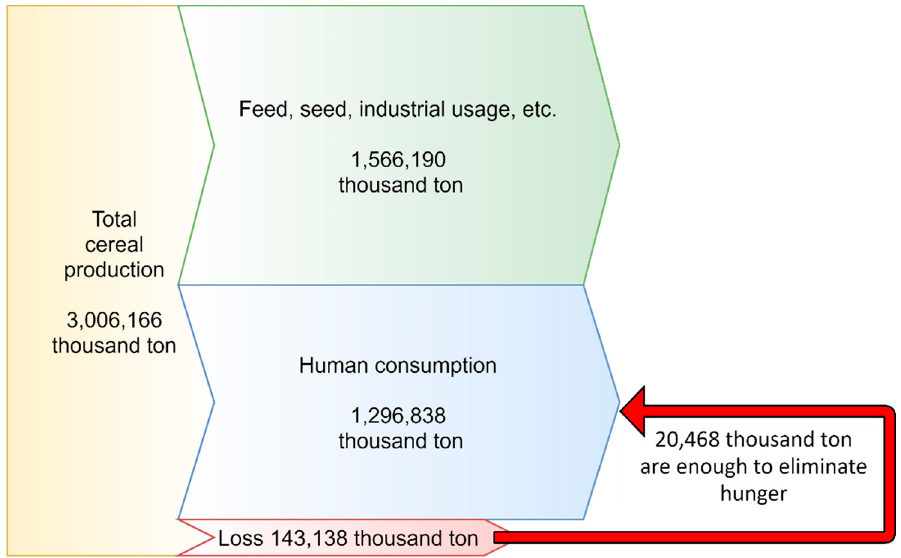
Figure 3. Presentation of the proportion of cereal production amount, enough to eliminate hunger (own drawing).